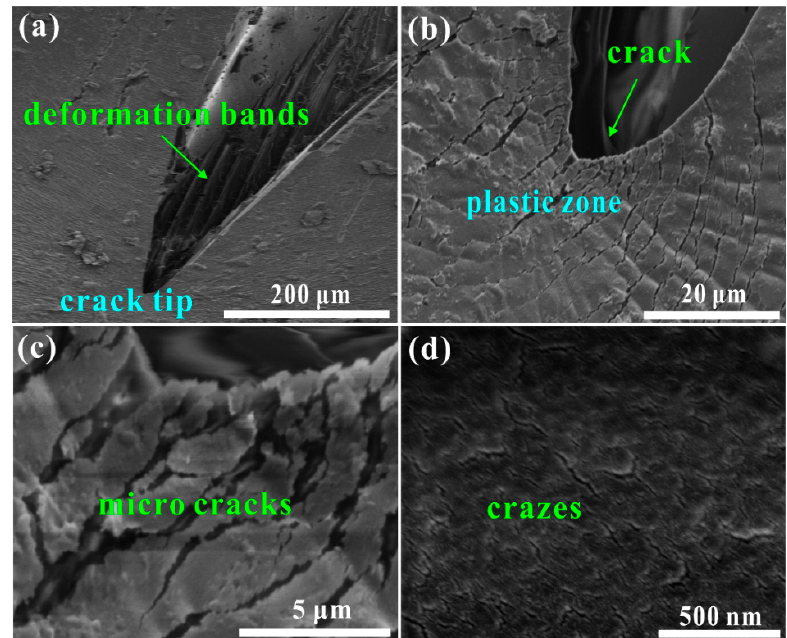
Figure 8. Post-test observations on the cracking behavior for revealing the mechanisms of strain energy absorption and impact resistance of the developed PUE material: ( a ) a growth crack with numerous parallel deformation bands inside the opening mouth; ( b ) a large plastic zone ahead of crack; and ( c , d ) high-density microcracks and crazes in the plastic zone.